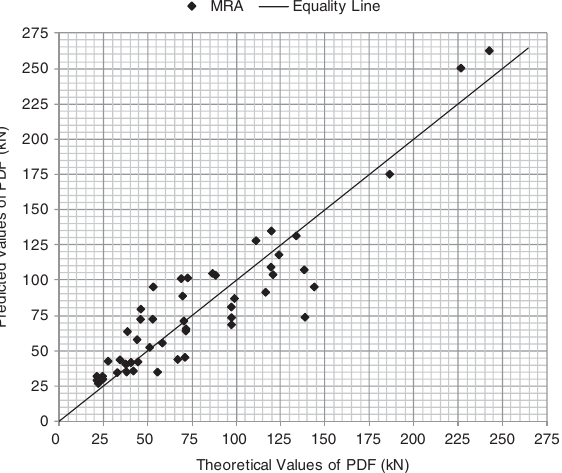
Fig. 16. Predicted TSAR values by multiple nonlinear regression vs. theoretical data (Set 2)